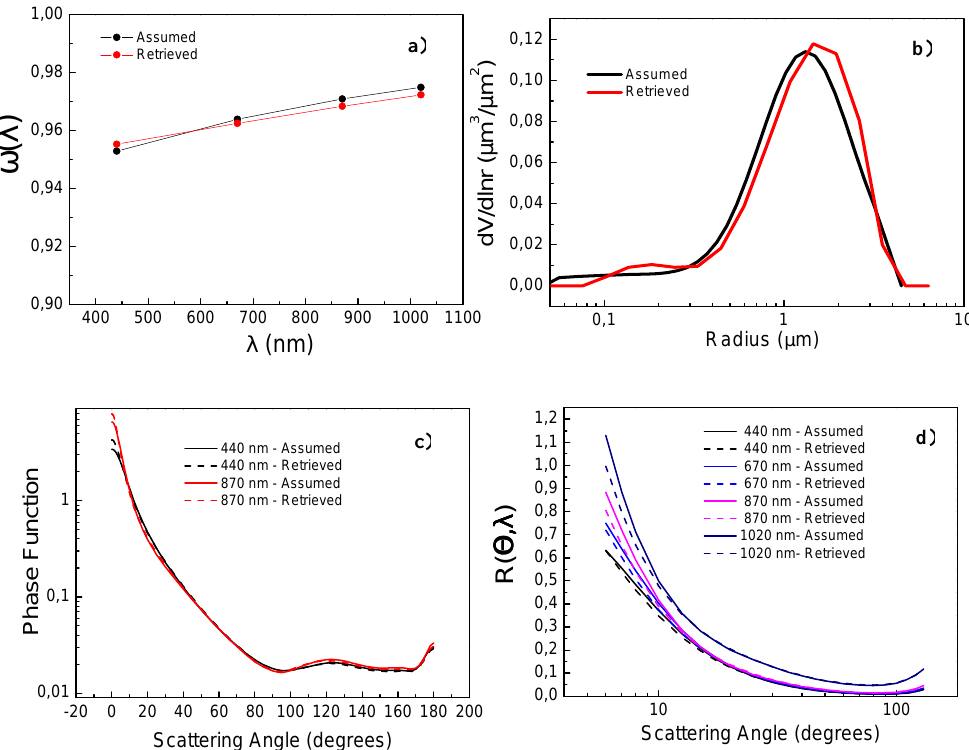
Fig. A1. Assumed and retrieved data for the analyzed case presented in Table A1: (a) spectral single scattering albedo, (b) volume size distribution, (c) spectral phase function, and (d) spectral normalized sky radiance in the principal plane.